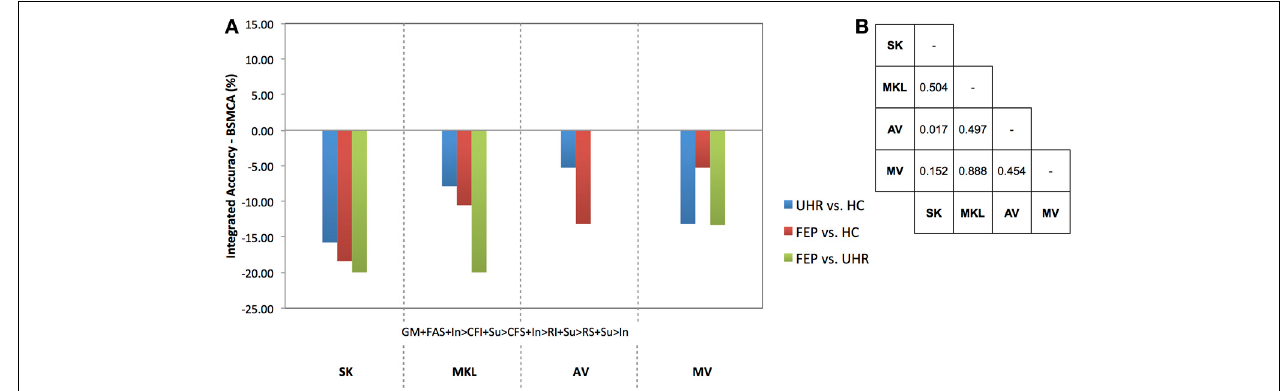
FIGURE 5 | (A) Difference between the integrated accuracy achieved using SK, MKL, AV, or MV, and the BSMCA, discriminating UHR and FEP subjects from HCs, and each other, using seven-way combinations of sMRI, DTI, and fMRI data. (B) Results of McNemar’s tests comparing subject classifications achieved by each integrative method collapsed across SVM contrasts and data combinations. SK, Un-weighted simple sum of kernels; MKL, Multi-Kernel